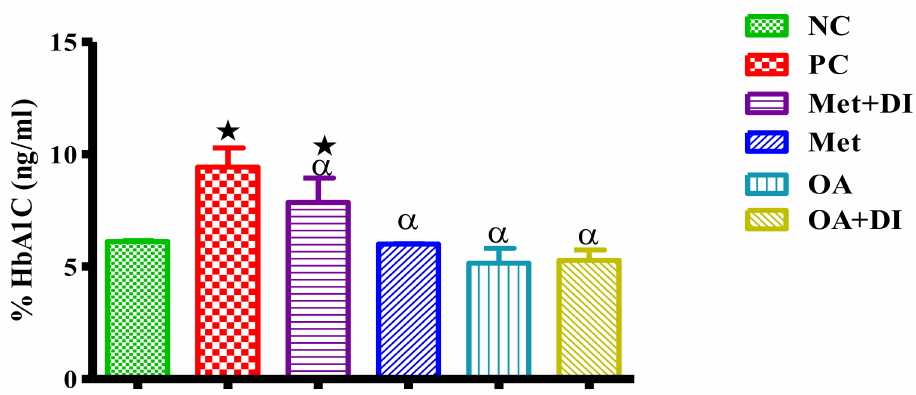
Figure 3. Effects of OA on the percentage of glycated haemoglobin concentrations of rats that continued with HFHC diet and those that changed diet or had diet intervention during treatment period. Values are presented as standard error of mean ± SEM. (cid:70) = p < 0.05 denotes comparison with NC; α = p < 0.05 denotes comparison with